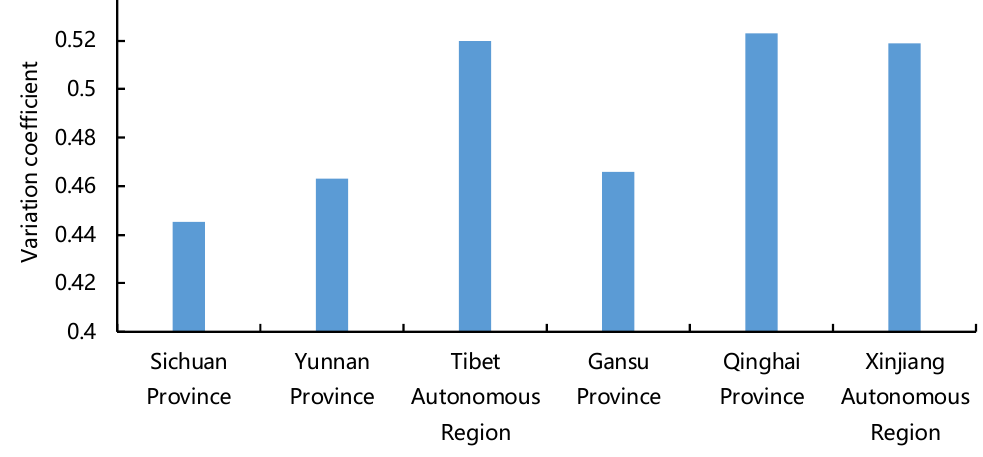
Figure 6. Spatial variation coefficients for human settlement quality in different provinces of the Qinghai–Tibet Plateau.